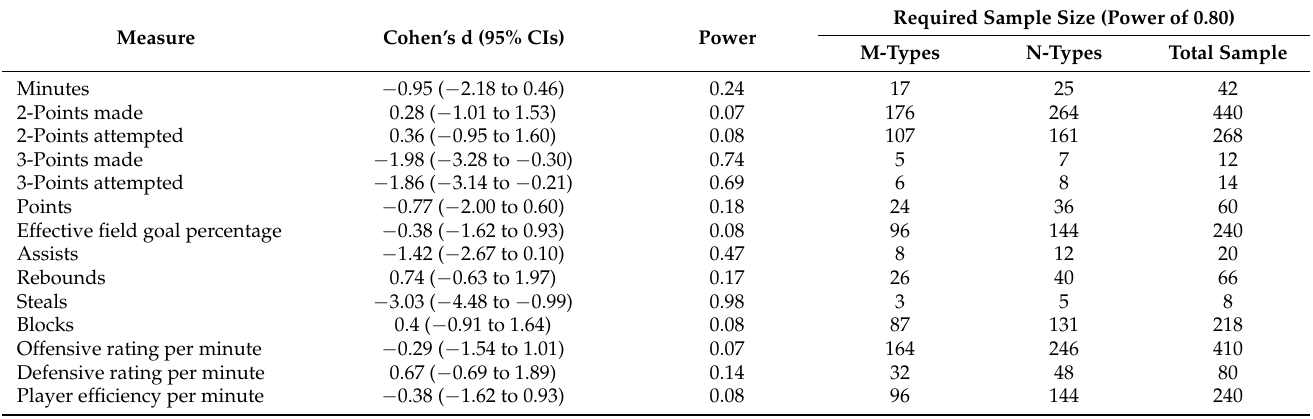
Table A1. Post hoc power analyses (two-tailed and α = 0.05) for comparisons of in-game performance measures between morning-types (M-types) and neither-types (N-types) during evening games in professional male basketball players.